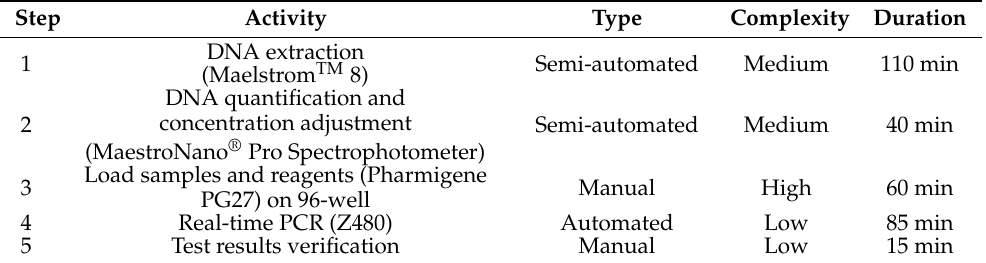
Table 2. Sequential flow of manual steps and the time required for each step in the detection of HLA-B*27.